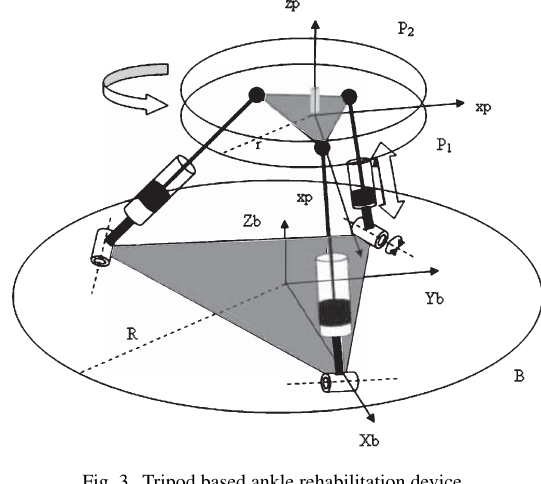
Fig. 3. Tripod based ankle rehabilitation